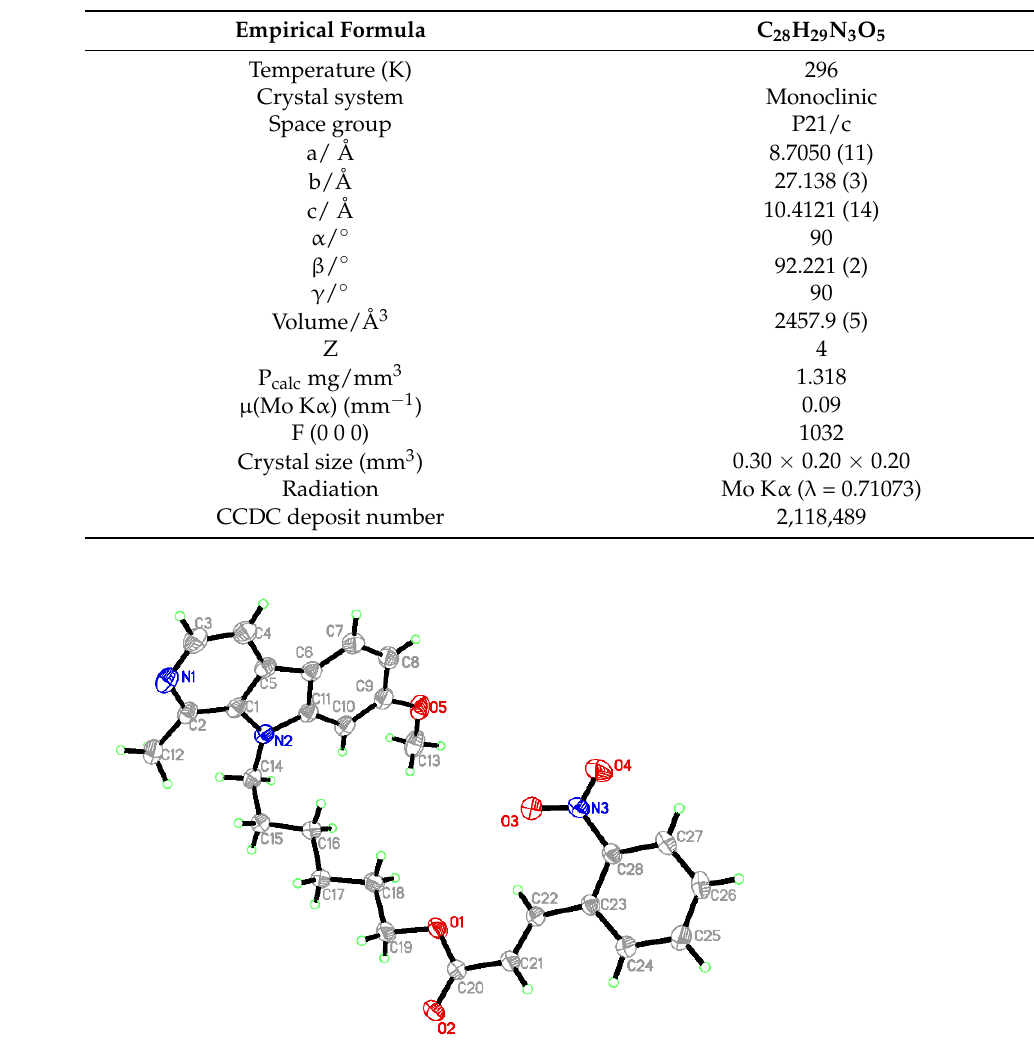
Table 2. Crystallographic data and structure refinement parameters of compound 7l .